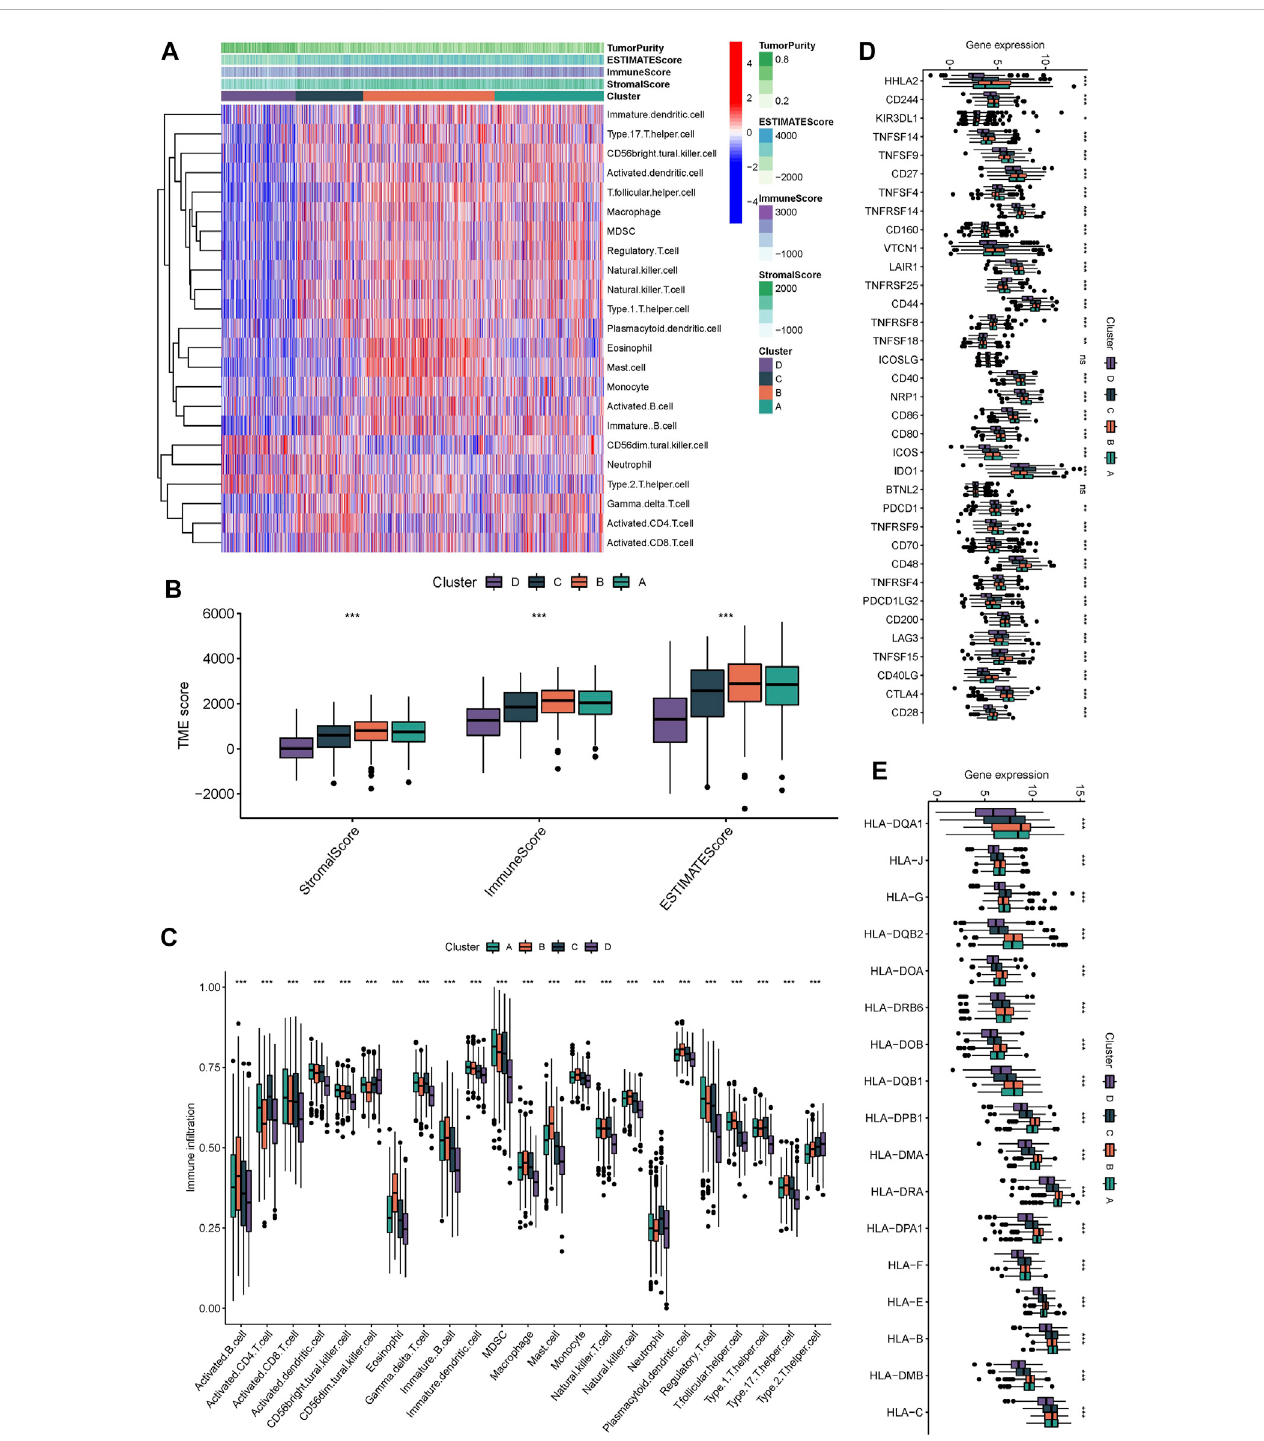
FIGURE 3 Immunologicalcharacteristicofdifferentmolecularsubgroups. (A) theheatmapdisplayedtheimmunocytesin fi ltrationindifferentmolecularsubgroups. (B) the stromalScore, immunoScore, ESTIMATEScore was calculated by “ ESTIMATE ” algorism. (C) the immunocytes in fi ltration in different molecular subgroups. (D,E) Expression levels of immunomodulators in different molecular subgroup, The median value: black lines in boxes, the outliers: black dots out